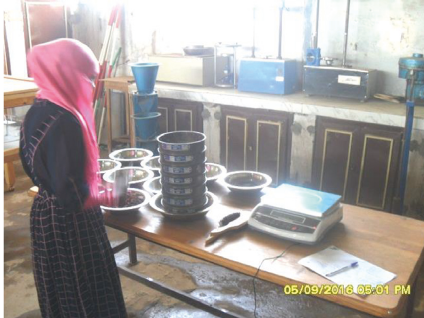
Figure 8: Soil classification tests at WMTC.